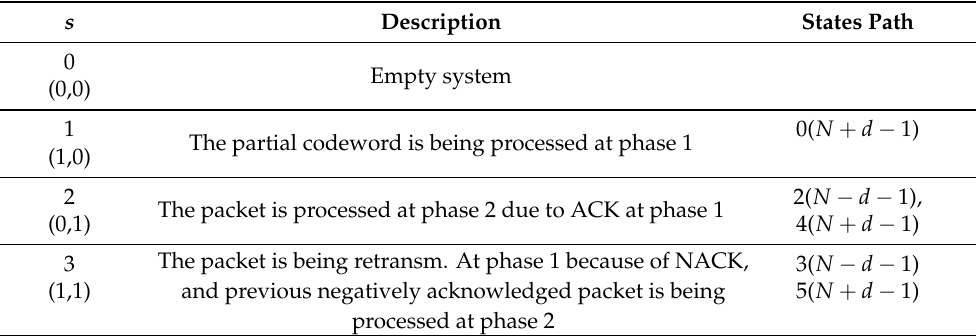
Table 1. Description of the phase states.